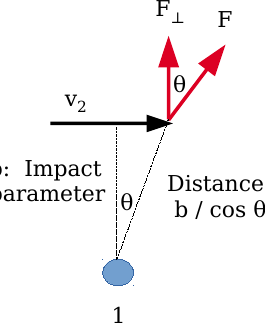
Figure 9. Geometry for the momentum transfer in a collision in the impact approximation [31] of a star (2) on either a spherical or a perpendicular cylindrical source (1), in the latter’s reference frame. The trajectory along v 2 is practically straight and with constant velocity, with the transferred momentum approximately perpendicular to